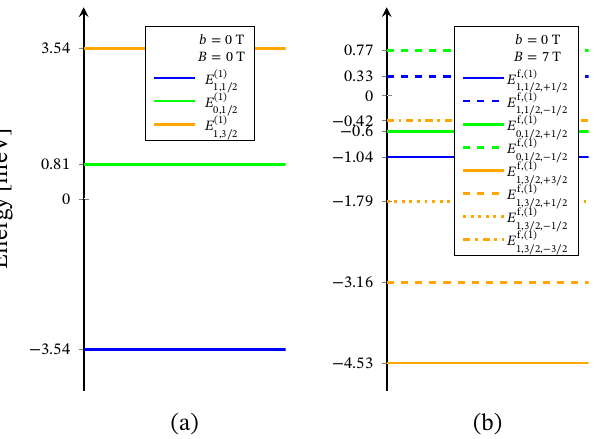
Figure 12. Effective energy spectrum of the compound [(Pc)Er{Pc{N(C 4 H 9 ) 2 } 8 }] · obtained with Hamiltonian (1) only with respect to the magnetization and susceptibility data from Reference [24], shown in Figure 10. Here, ( a ) depicts the predicted energy levels sequence for the case B = 0 T and ( b ) with applied field of 7 T.